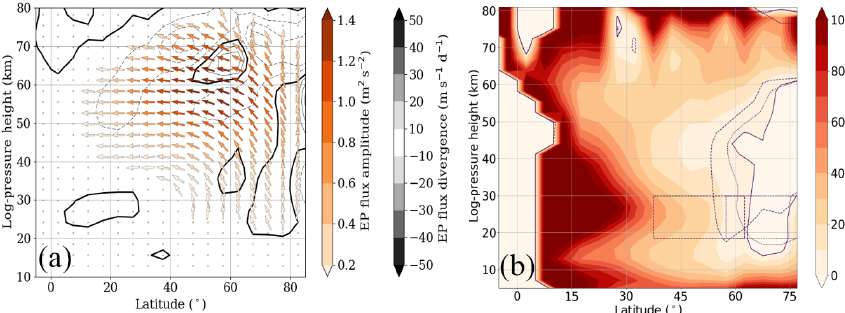
Figure 9. Zonal mean EP flux of SPW 1 of the Ref simulation (a) . Contour lines show the EP flux divergence, and dashed lines denote negative EP flux divergence. The refractive index for SPW 1 for the Ref simulation (b) with a thicker zero line. The position of the H3 (H7) GW hotspot and the respective zero line is represented by the dashed (dotted) violet line. Both panels represent the last 30d of the simulation.